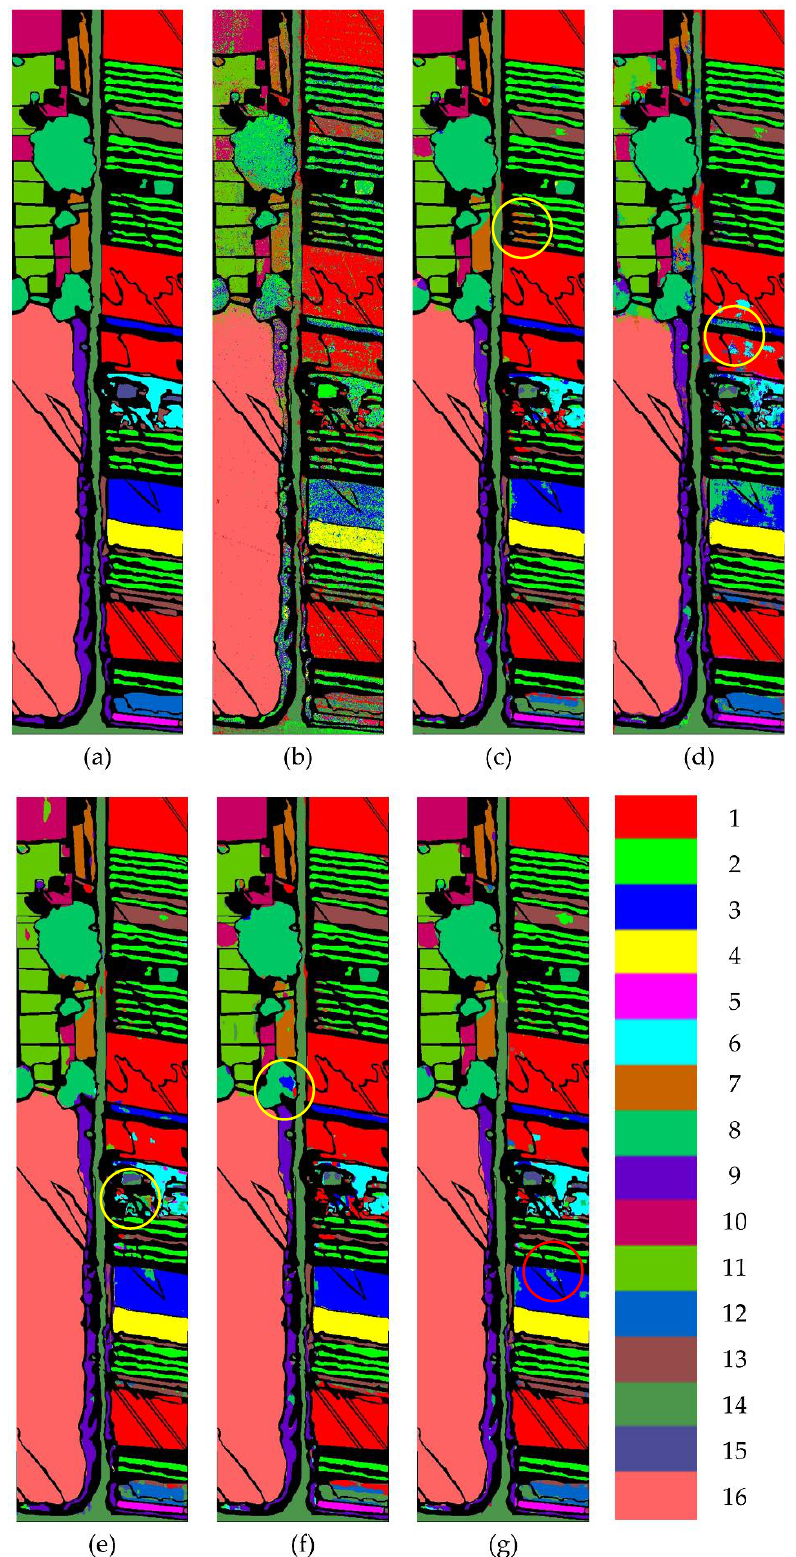
Figure 5. Ground truth and classification results of the WHU dataset: ( a ) ground truth; ( b ) SVM; ( c ) 2D CNN; ( d ) 3D CNN; ( e ) 3D–2D–1D CNN; ( f ) 3D–2D–CBAM–1D CNN; ( g ) MDAN (3D–2D–CBSM–1D CNN). This figure shows the classes with lower classification accuracy in the yellow circle and the red circle.